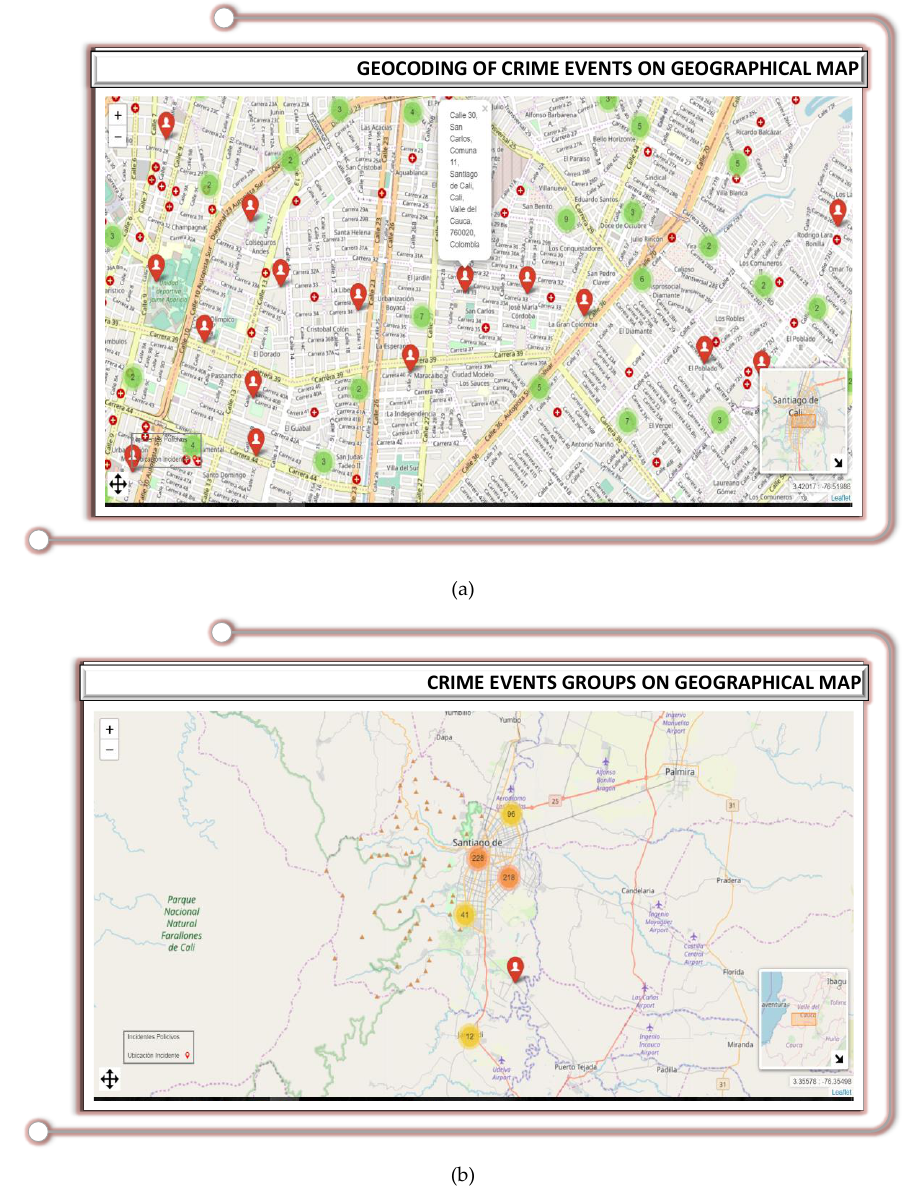
Figure 8. G eocoding and Groupings (capture): (a) Criminal events geocoded to street address.; (b) Figure 8. Geocoding and Groupings (capture): ( a ) Criminal events geocoded to street address.; Criminal events grouped by location. ( b ) Criminal events grouped by